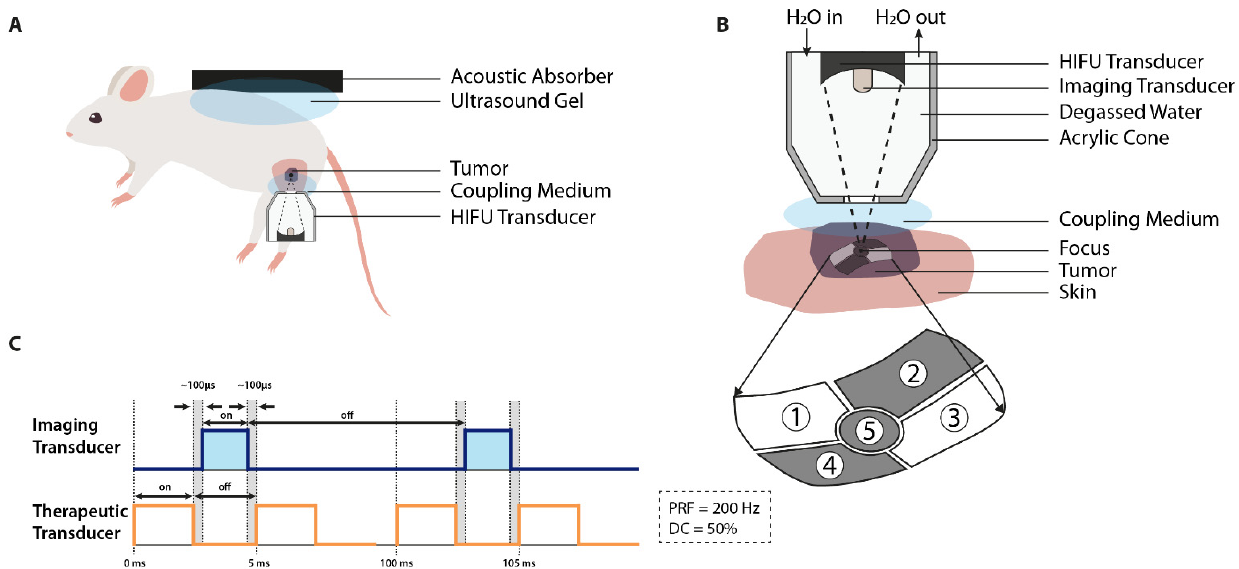
Figure 5. Illustrations of the high-intensity focused ultrasound (HIFU) device for hyperthermia application. ( A ) Both the entrance and the exit of the ultrasound wave should be guided by a coupling medium. At the interface between the HIFU transducer and the tumor, the coupling medium ensures acoustic wave propagation. Additionally, at the other side, where the wave exits the tissue, the presence of a medium in combination with an acoustic absorber prevents far field heating within the animal due to energy reflection; ( B ) the HIFU coupling cone holds both the transducer(s) and the coupling medium. Together, the cone configuration and the coupling medium determines the depth of focus. Incorporation of a split beam transducer allows for application of various heating geometries (element 1–5); ( C ) the sequence control for the therapeutic and imaging transducer. Acoustic interference between the transducers is prevented by non-simultaneous operation. Ultrasound imaging is performed during the “OFF” period of the therapeutic transducer with an interval of ~100 μ s. Image B and C are adapted from Wu et al., Seip et al., Lee et al., and Farr et al. [117,121,122,134]. Table 4. Overview of the preclinical studies on application of local hyperthermia using focused ultrasound (FUS) sorted by year of publication and animal model. Tumor Device